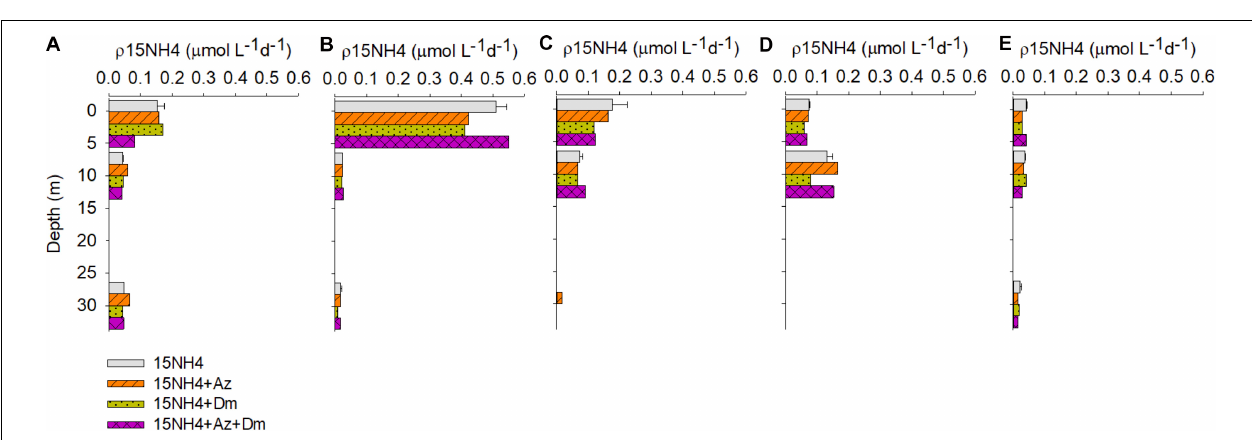
all depths (paired t -test > 0.05). The chemoautotrophic